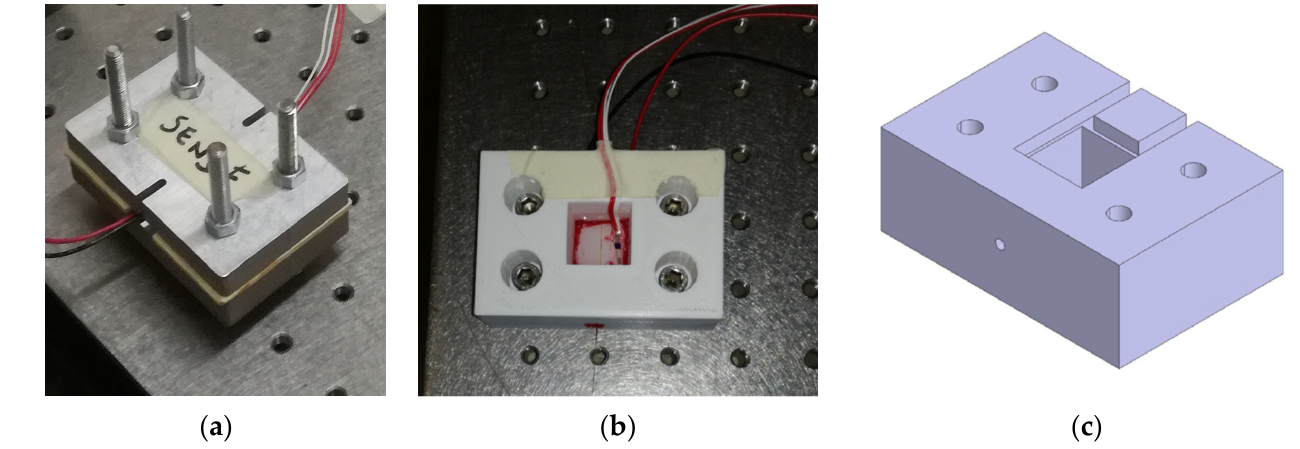
Figure 7. Bolted system holding the FBG sensor ( a ), cavity filled with water ( b ), 3D-printed support with measurement room filled with water, and hole for FBG sensor access ( c ).